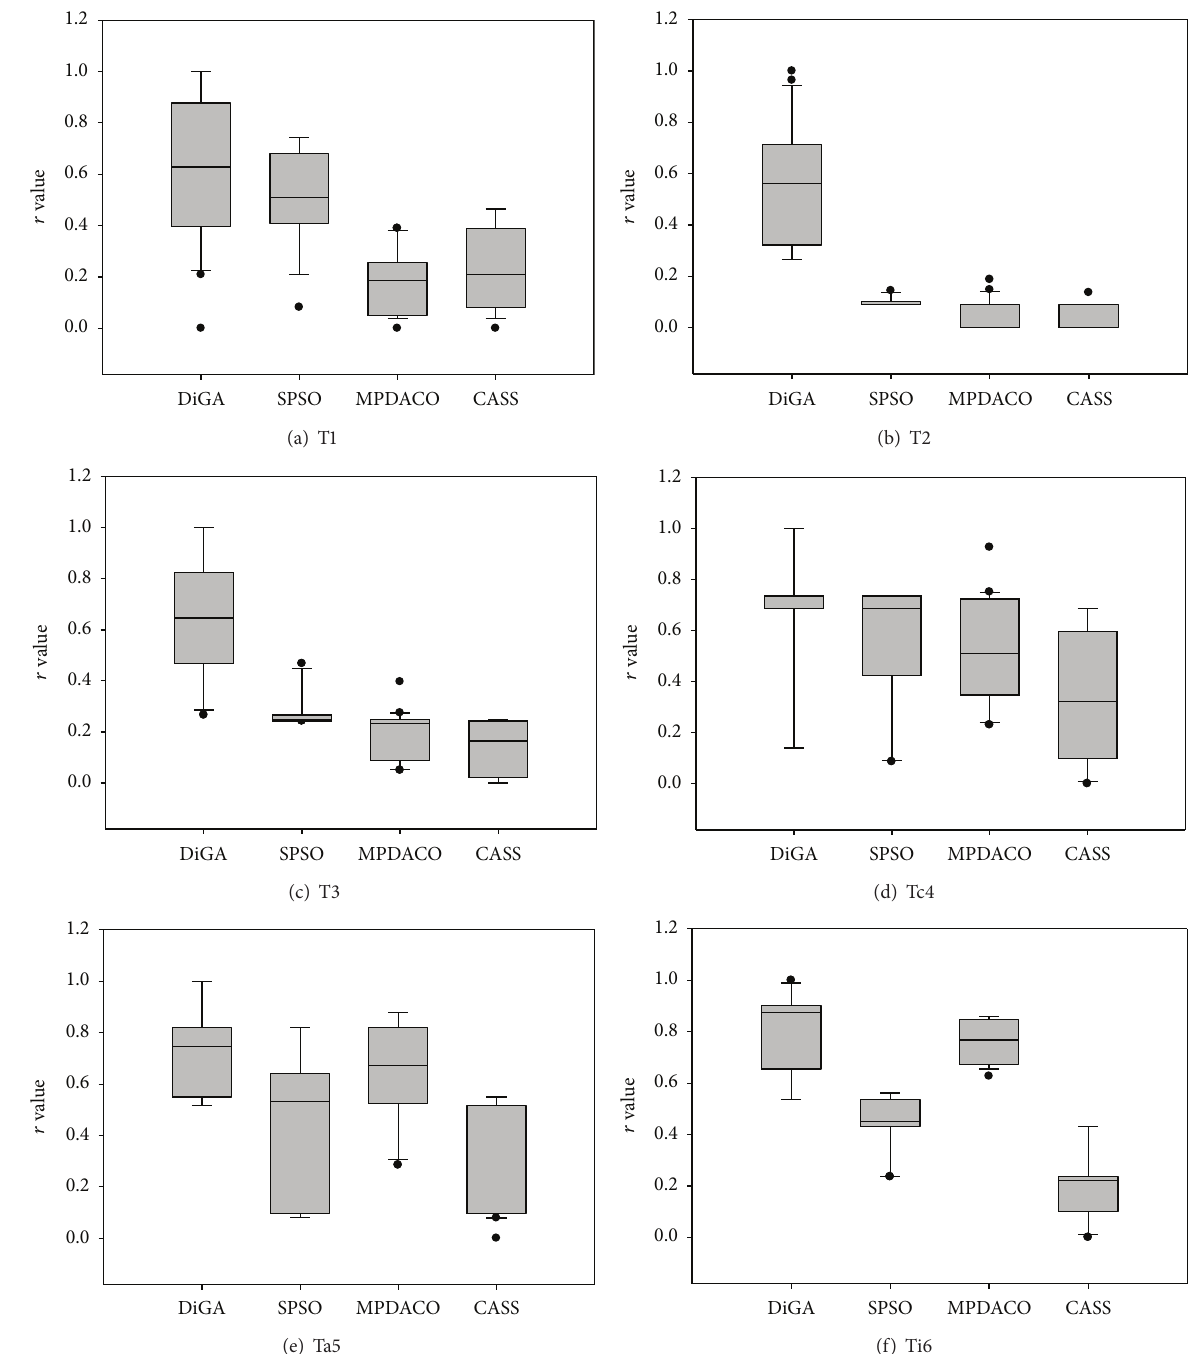
Figure 2: The Boxplots of the 𝑟 value